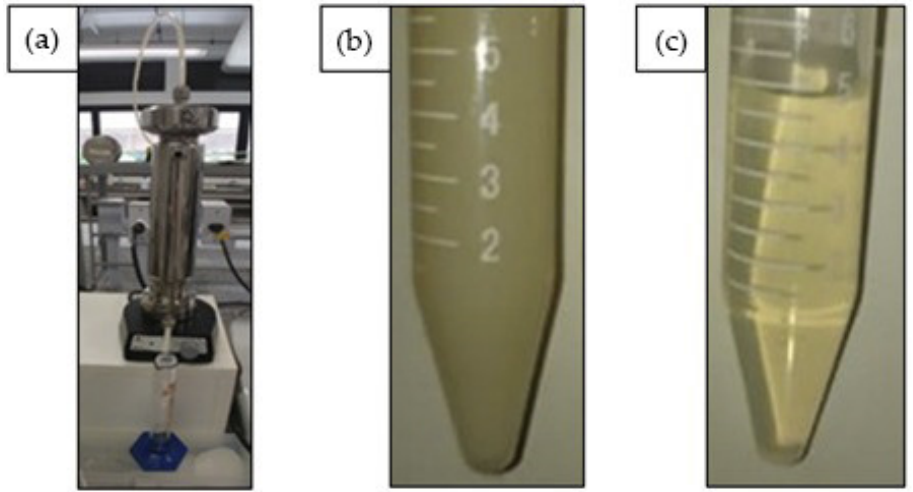
Figure 4. Hydrolyzates microfiltration. ( a ) Microfiltration equipment. ( b ) Feed: Chicken feather keratin hydrolyzate. ( c ) Permeate: Chicken feather keratin hydrolyzate.